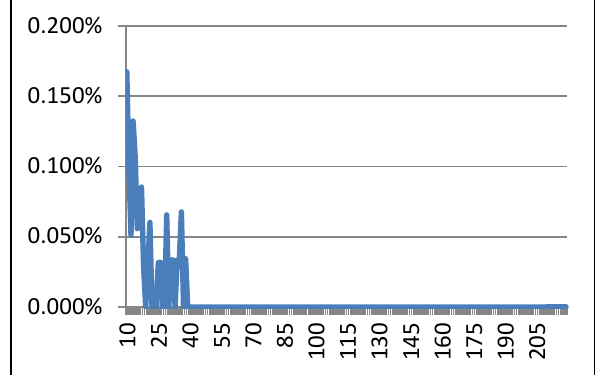
Fig. 4. Verification park k = 1, sequence length growing, the error percentage vertical axis: error percentage horizontal axis: the length of prime set From Fig. 4, when the size of prime set is greater than 38, the error percentage goes to zero.